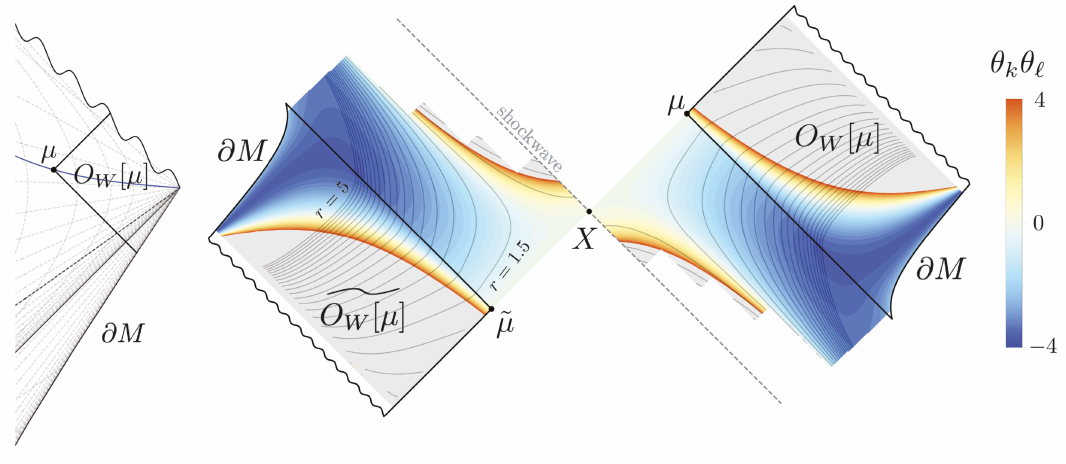
Figure 4. To the left, we have zoomed into the outer wedge O W [ µ ] of a marginally trapped surface µ on the spacelike section of the holographic screen in figure 2. On the right, we show the coarse-grained spacetime corresponding to µ in the regions where we have been able to obtain the metric numerically. The black contour lines show surfaces of constant area radius, saturating at r = 5 and with spacings of δr ≈ 0 . 2 . The colored contours show the product of the null expansions θ constant − r surfaces, with gray regions corresponding to θ the HRT surface X carries no null energy, but does source a discontinuity in the inaffinity of ‘ a , which is the null vector along the direction of the shockwave. The quantity ‘ a ∇